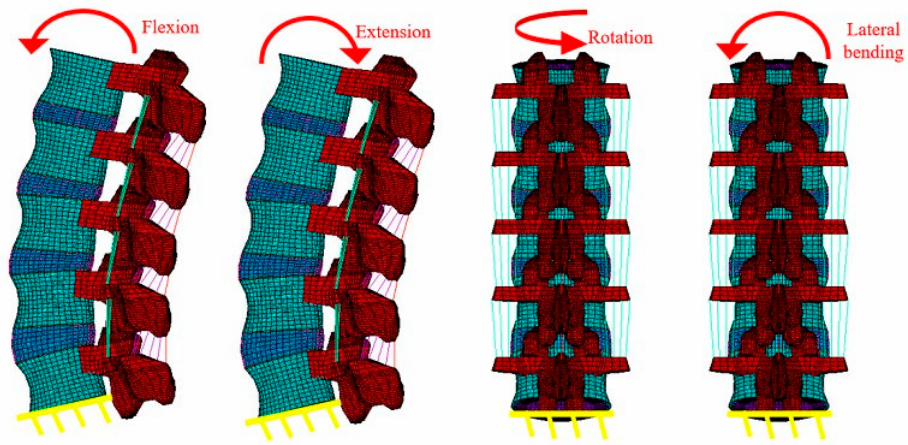
Figure 4. Different loading conditions on the lumbar spine.